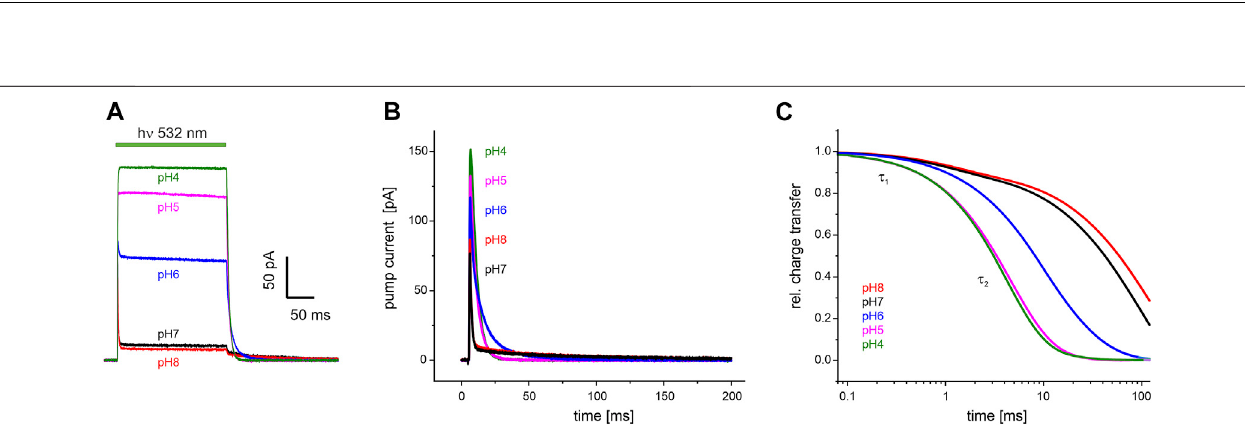
FIGURE 5 | Electrophysiological recordings on Um Rh1 at different extracellular pH. Representative traces of whole-cell patch-clamp experiments on NG108-15 cellsheterologouslyexpressing Um Rh1-eYFP. (A) Stationarycurrentsundercontinuousilluminationwitha532 nmDPSSlaserat0 mVcommandpotentialanddifferent extracellular pH as indicated. (B) Single-turnover measurements of Um Rh1 at different pHs recorded after applying a light pulse of < 1 ms. Current amplitudes are highest at acidic pH. At alkaline but not acidic conditions, a pronounced slow component of the current decay is visible. (C) Kinetics of charge transfer at different pH plottedonthelogarithmic timeaxis andnormalizedtothemaximum chargerecordedat therespectivepH. Twoexponentials(with τ 1 and τ 2, Table1 )arerequiredto adequately fi t the data.